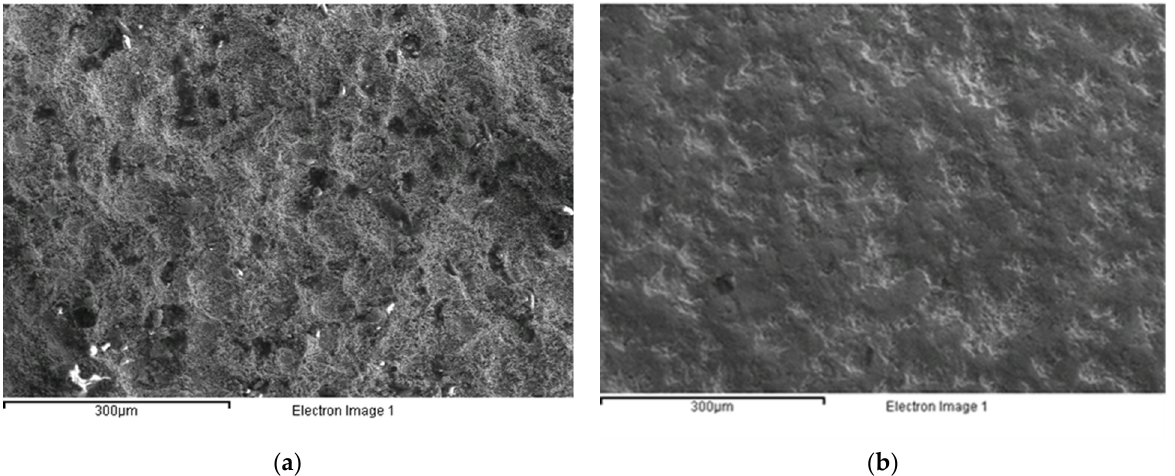
Figure 1. Morphology of sample after HVOF coating ( a ); and after HVOF and shot peening ( b ).